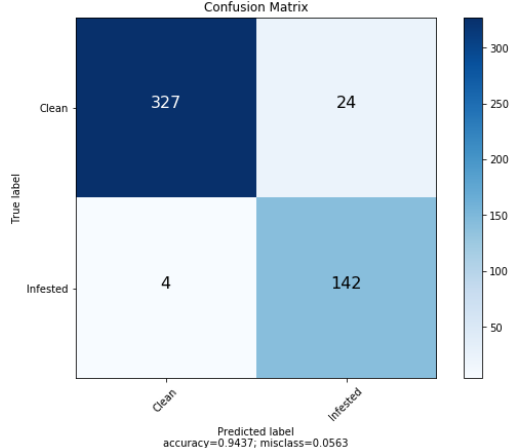
Figure 8. Automatic verification of borers’ infestation in trees in the field data based on a 20% holdout set. (Left) Confusion matrix of a using an Xception model. (Right) Precision ( P ), Recall ( R ) and F1 scores. Table 2. Precision (P), recall (R) and F 1 score metrics on a random 20% holdout data for the best performing model.